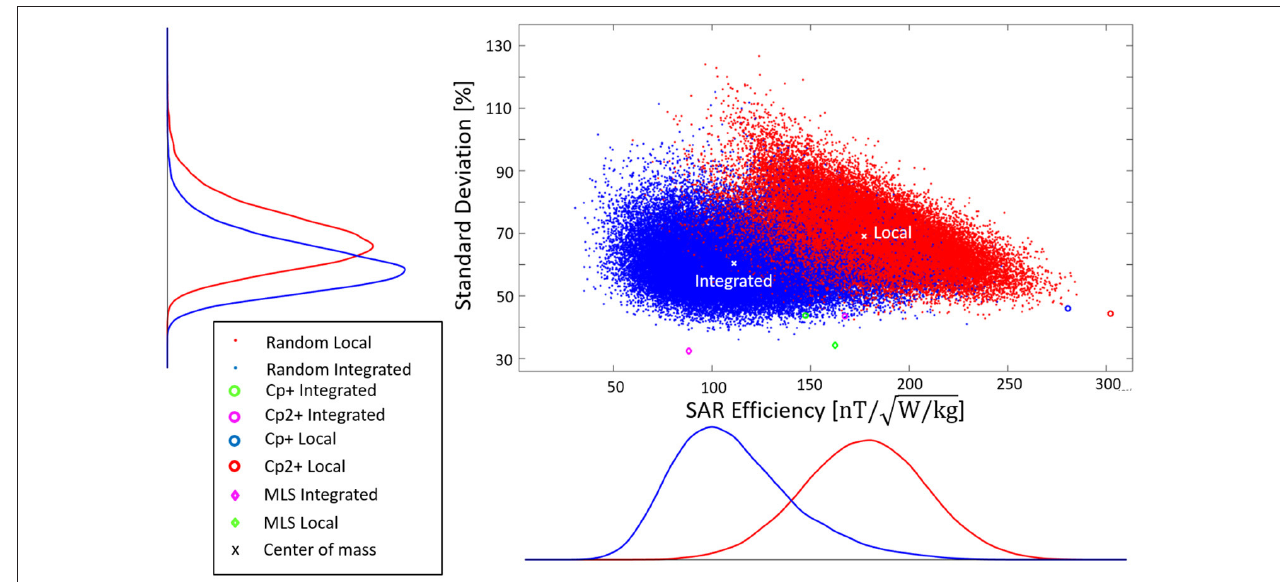
FIGURE 2 | Comparison of homogeneity and SAR efficiency of the local and integrated coils. Standard deviation in [%] of B + 1 in a central axial slice versus SAR efficiency in [nT p W / kg] for 50,000 random shims and for a MLS shim for both the local array and the integrated array including kernel density plots is shown. The center of mass for each set of shims is indicated with a white cross. While the integrated array shows a slightly better overall performance in terms of standard deviation as a measure of homogeneity, the local array performs better in terms of SAR efficiency. For reference, the first two circular polarized modes (CP modes) for both arrays are